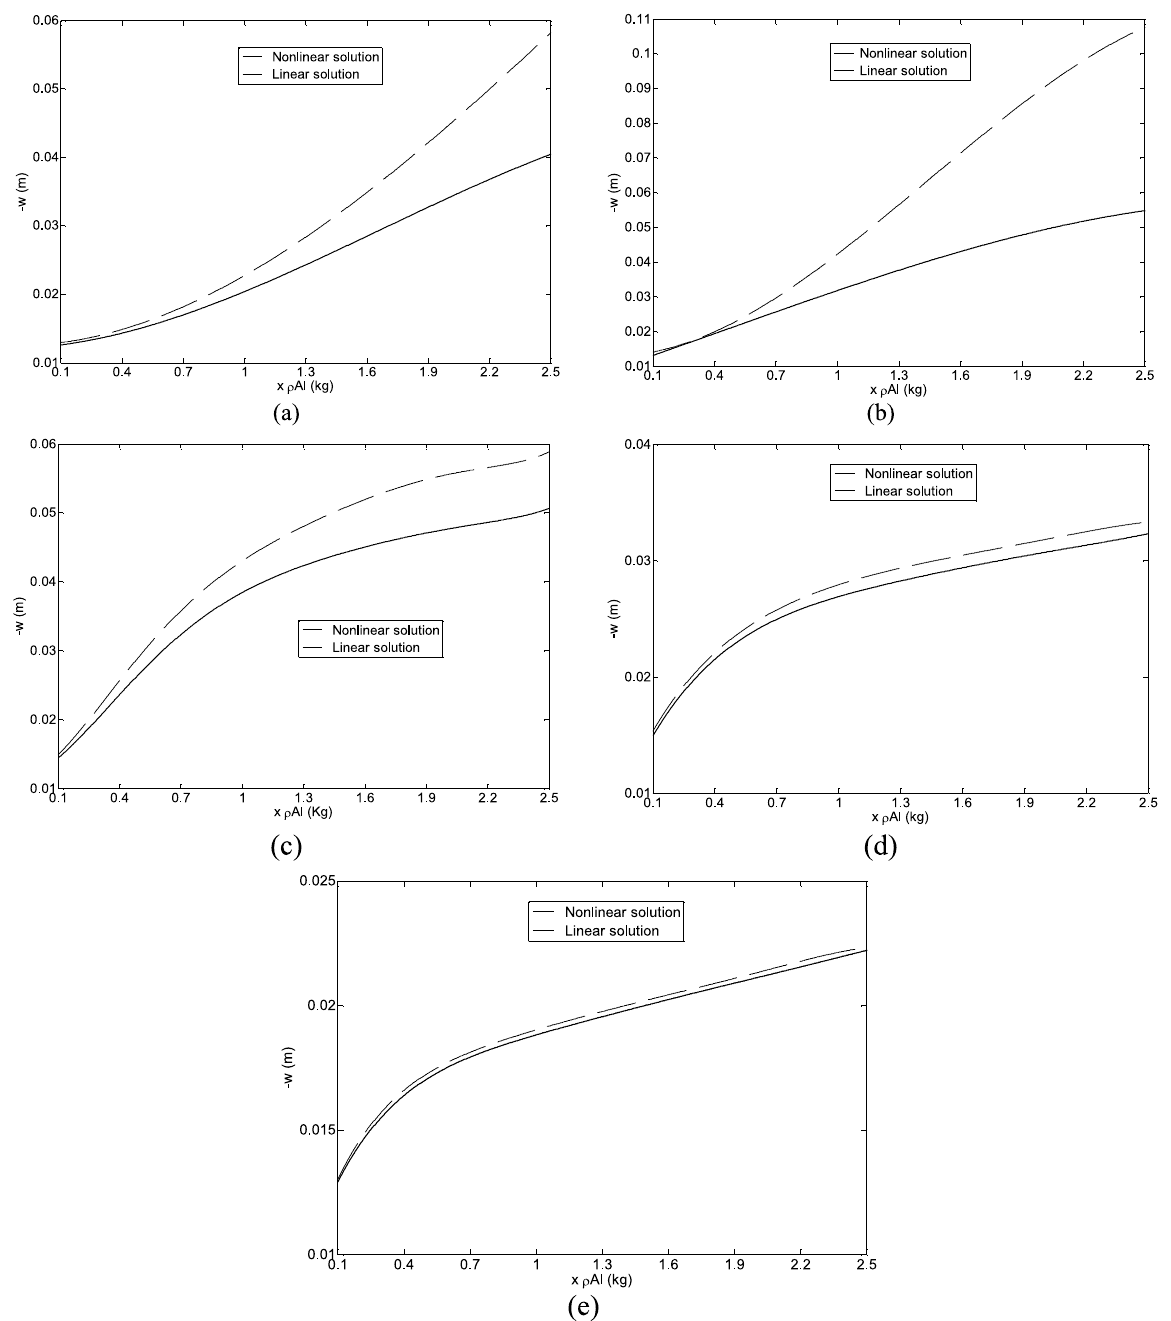
Fig. 5. Variation of the maximum dynamic response of a point at the middle of a self-weight Timoshenko beam with θ = 36 ◦ vs. different values of the moving mass for different velocity ratios; (a) α = 0.25, (b) α = 0.5, (c) α = 0.75, (d) α = 1, (e) α = 1.25. (—–) nonlinear solution, ( ) linear